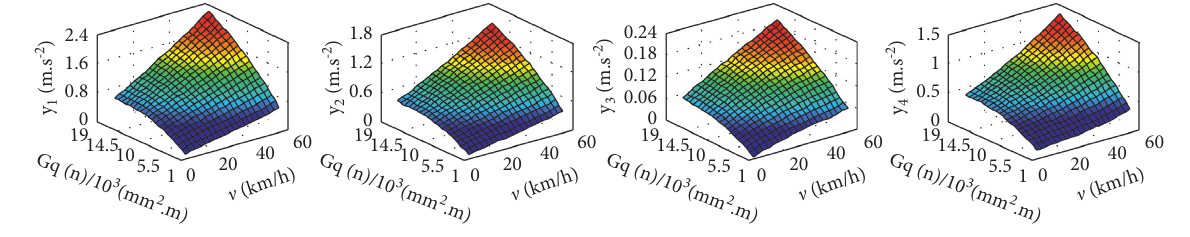
Figure 26: RBF neural network model fitting. Table 14: R 2 of approximate